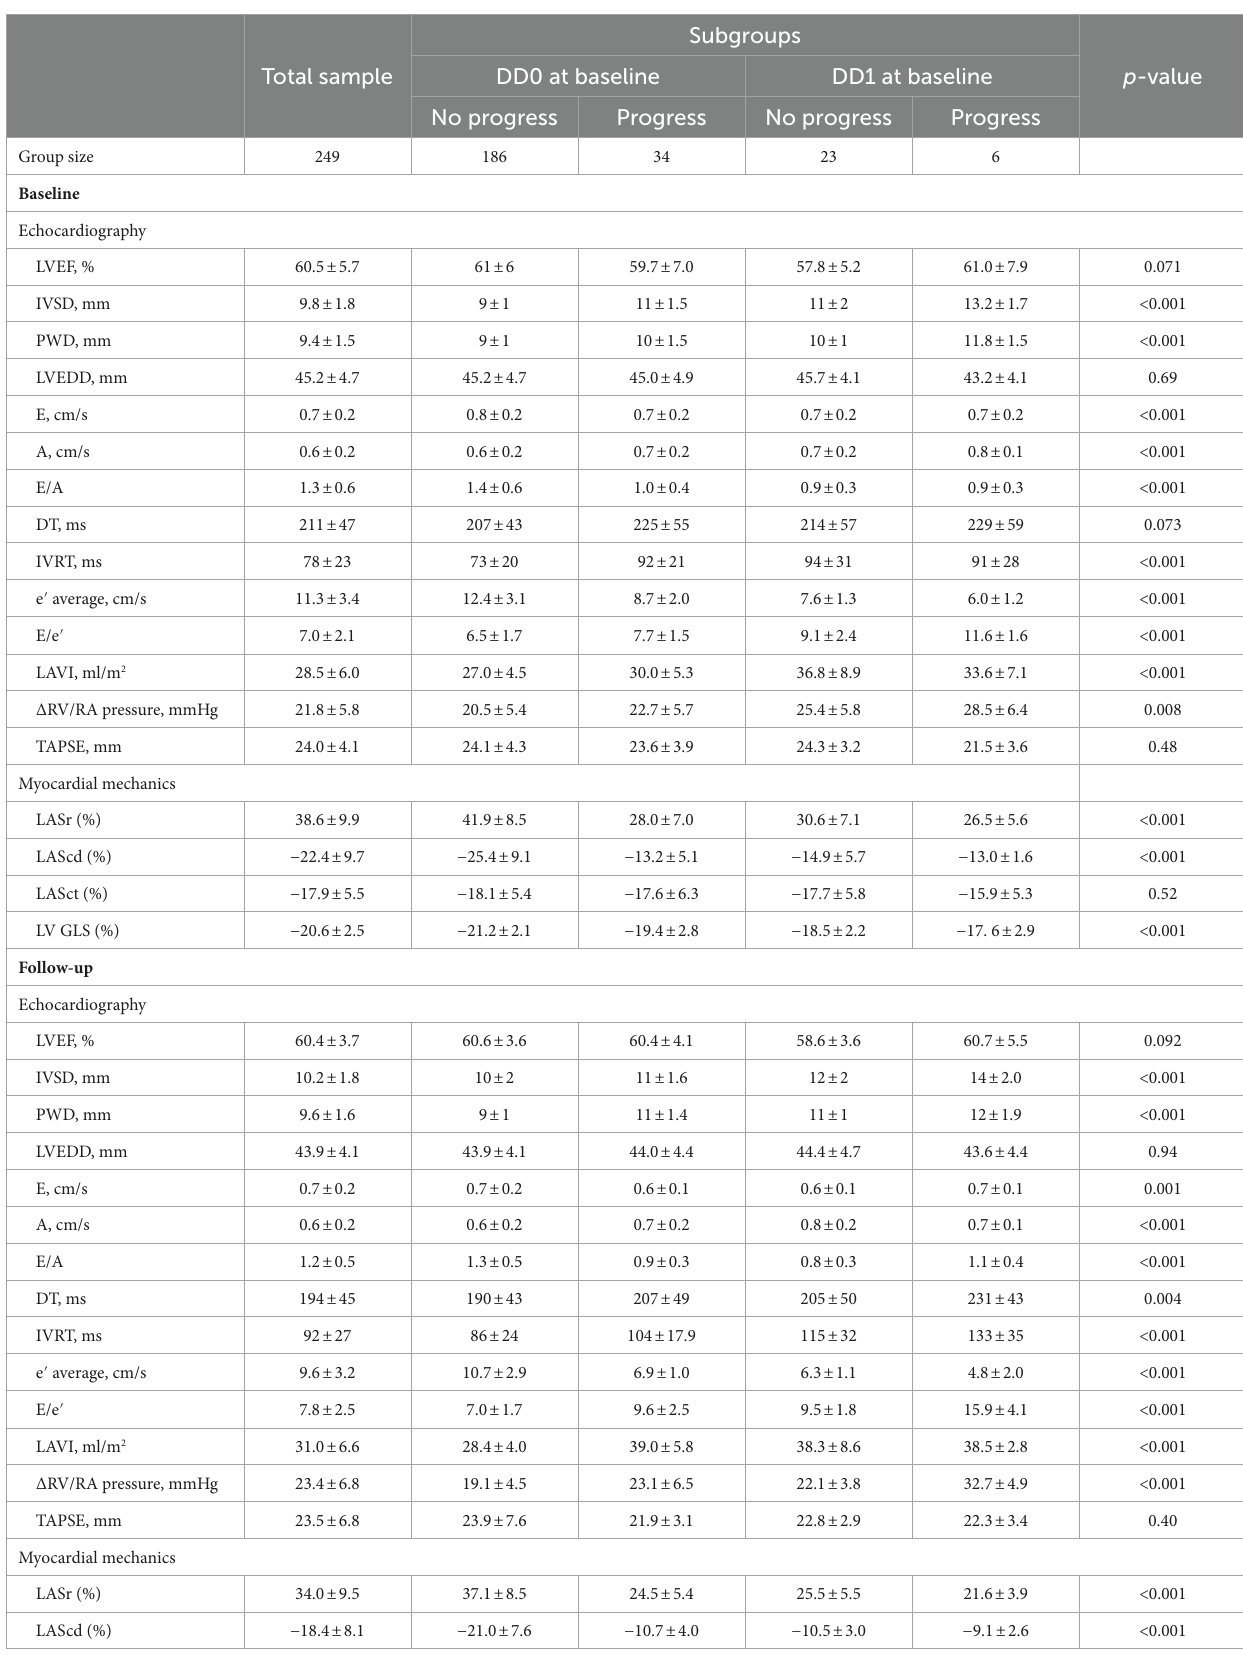
TABLE 2 Echocardiographic characteristics and myocardial